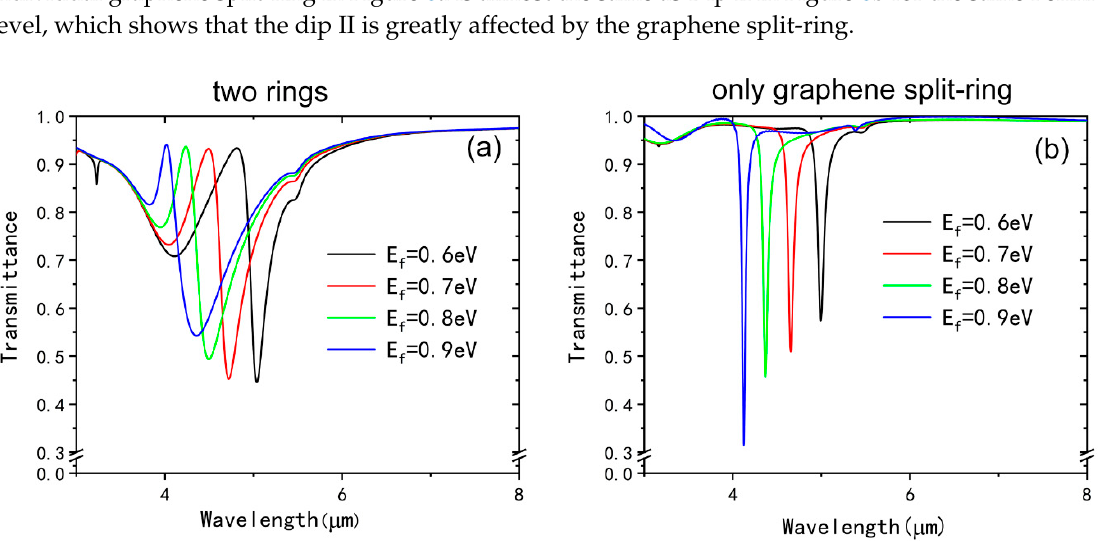
Figure 6. ( a ) Transmission spectra of the two rings with different Fermi levels of the graphene split-ring. ( b ) Transmission spectra of the individual graphene split-ring with different Fermi levels.